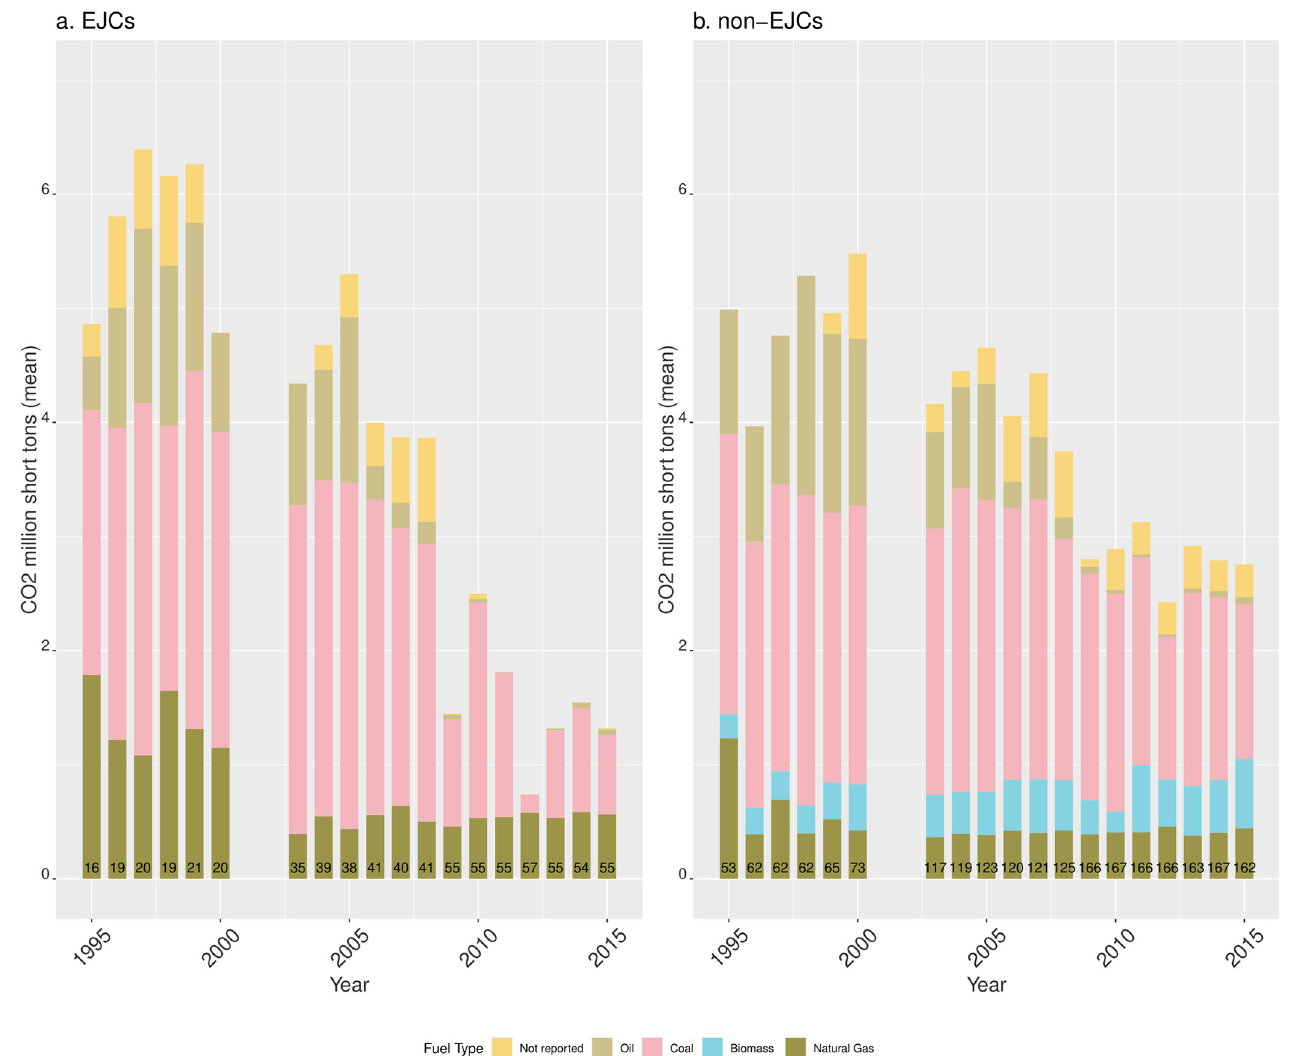
Fig 7. Mean annual CO 2 emissions by fuel type from EGUs in RGGI sited in (A) EJCs and (B) non-EJCs. The numbers at the bottom of the bars indicate the number of reporting units for each